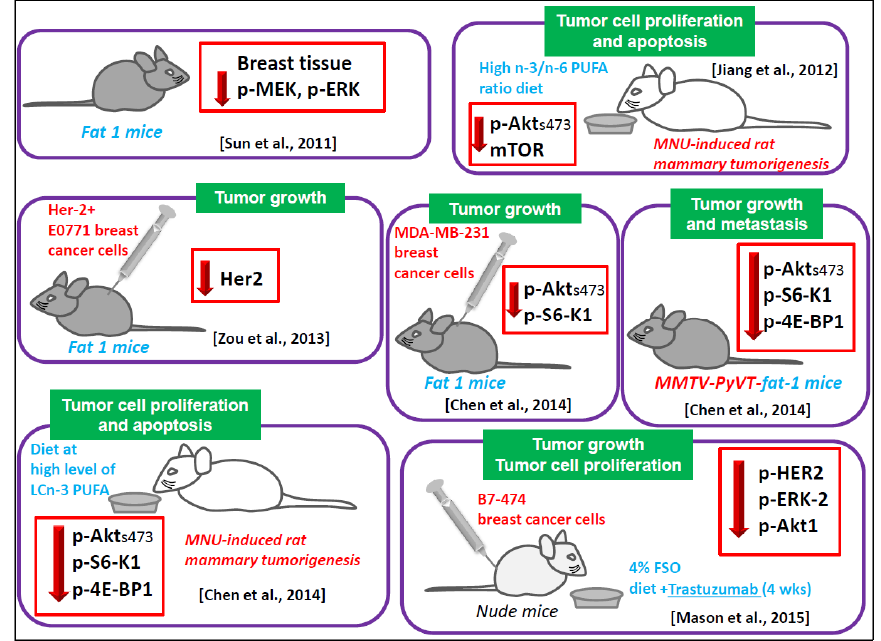
Figure 6. Outline of the main results of the reports investigating LCn ‐ 3 PUFA regulation of ERK and AKT and their upstream or downstream components in the ERK and phosphoinositide survival pathways in in vivo animal models. The green labels show the main features, functions, or processes of the tumors/breast cancer cells growing in vivo and regulated in an antineoplastic sense by LCn ‐ 3 PUFA. The red arrows indicate a negative regulation by LCn ‐ 3 PUFA. The red captions explain the treatment performed or the animal models used to obtain the development of breast tumors in the animals. The light blue captions describe the treatment or animal models used to obtain animals with Fat ‐ 1 mice with polyoma virus middle T oncogene mammary tumorigenesis model (MMTV ‐ PyVT) mice.